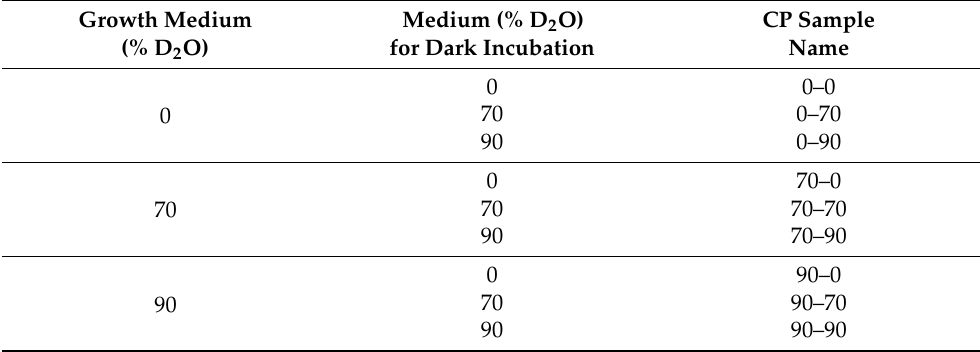
Table 1. Commitment point (CP) samples as defined by the combination of growth media and media used for dark